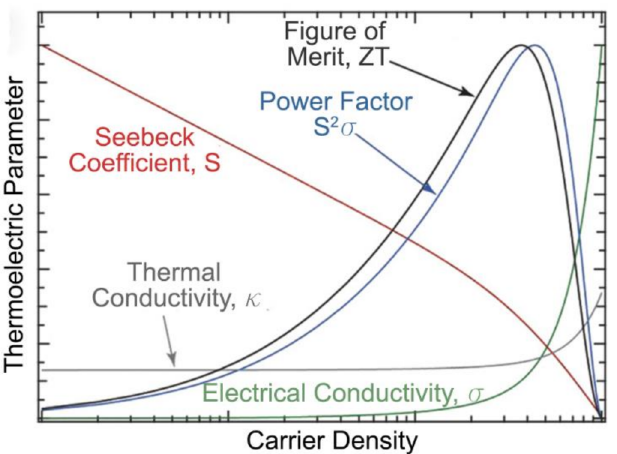
Figure 1. Interdependence of various TE parameters that influence ZT of the material, illustrating the challenge of optimizing ZT [33]. Data of actual semiconducting single-walled carbon nan- otube (SWCNT) networks, reproduced with permissions [33]. Copyright 2018 WILEY-VCH Verlag GmbH & Co. KGaA,